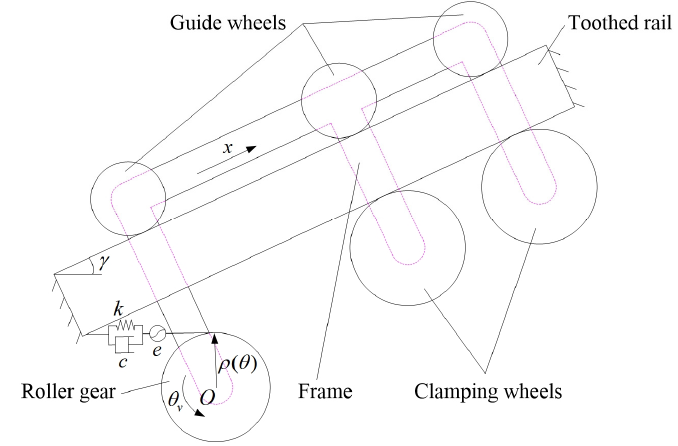
Figure 6. Dynamic model of the MSEMT.